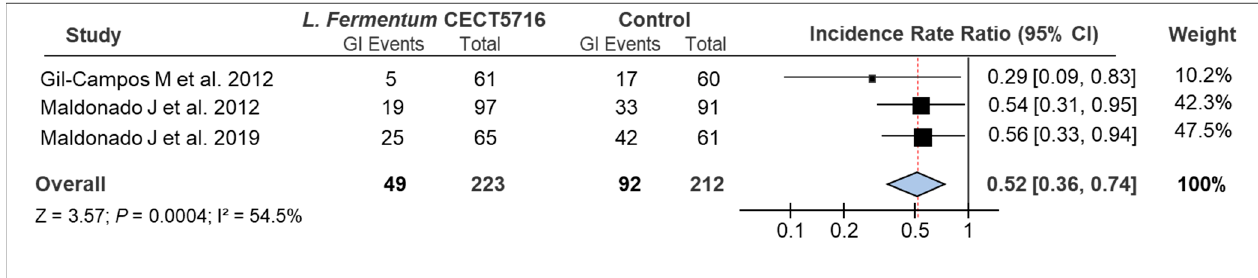
Figure 2. Forest plots illustrating the effect of L. fermentum CECT5716 interventions on the incidence of GIs in formula-fed infants. Abbreviations: CI, confidence interval; GI, gastrointestinal infection.